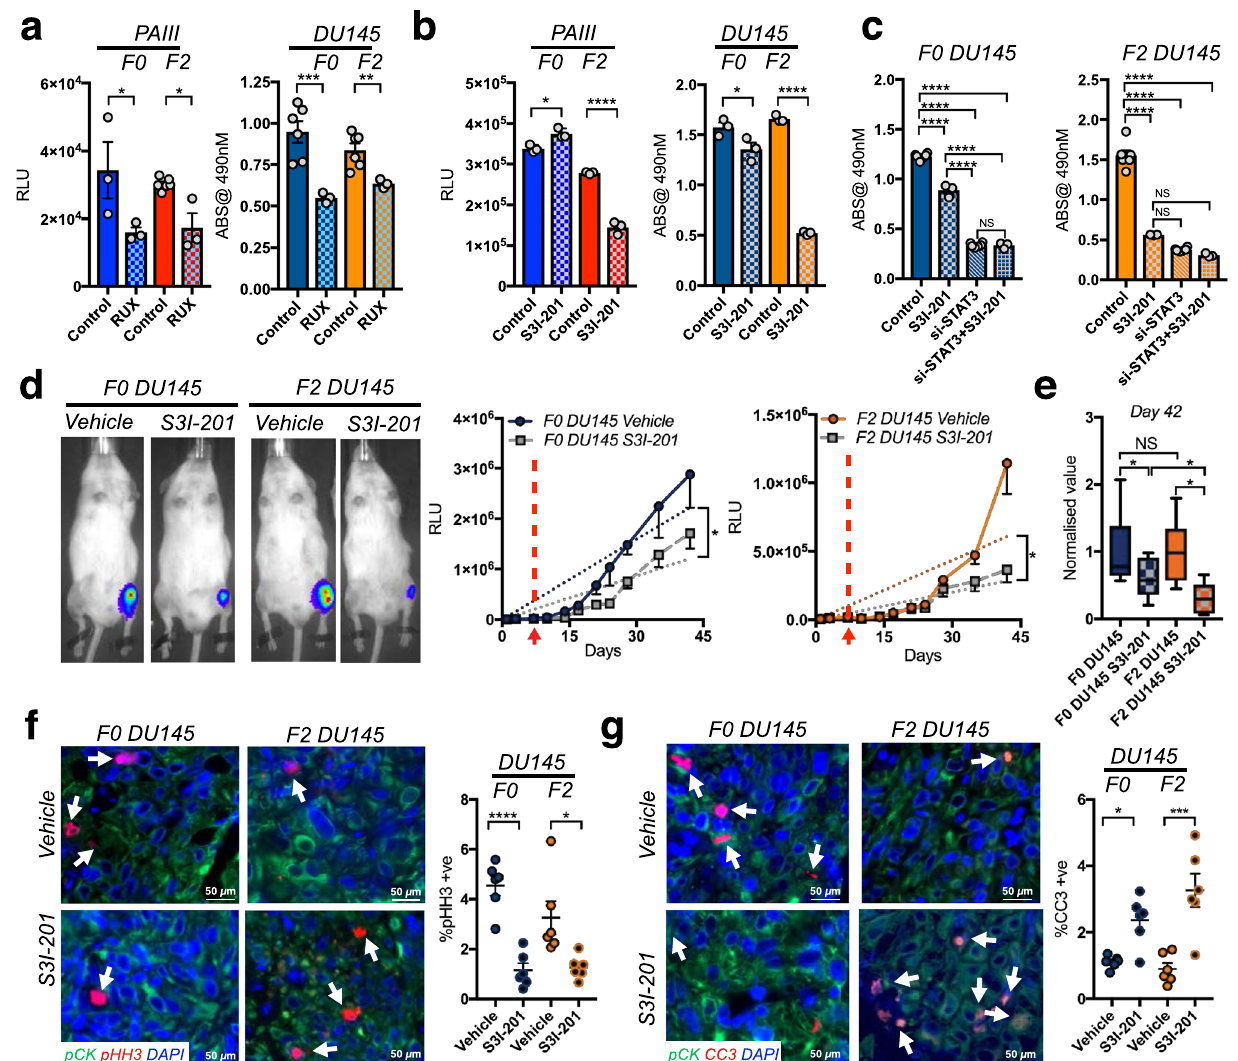
Fig. 7 STAT3 inhibition impairs the growth of MSC-selected prostate cancer in vitro and in vivo. a , b Parental (F0) and MSC-selected (F2) cell lines treated with vehicle control (Control) or the JAK2 inhibitor ruxolitinib (RUX)/STAT3 inhibitor (S3I-201) for 24 h. c F0 and F2 DU145 control (scr-siRNA) or STAT3 silenced (si-STAT3) cells treated with vehicle or S3I-201 for 24 h. d F0 and F2 DU145 growth over time in the presence or absence of STAT3 inhibitor, S3I-201 ( n = 10/group). Representative images of bioluminescence in each group are shown at day 35-time point. Arrow and dashed line represent time of treatment initiation. Graphs illustrate collected RLUs over time for each group. Error bars represent the mean ± SEM and linear regression was used for statistical analysis. e S3I-201 effect on F0 and F2 DU145 at day 42 normalized to respective controls. Box and whisker plots show min to max values obtained. f , g Ex vivo analyses from study endpoint of proliferative and apoptotic indices using phospohistone H3 (pHH3; red arrows; f ) and cleaved caspase 3 (CC3; red, arrows, g ), respectively. Pan-cytokeratin (green) was used to identify prostate cancer cells. Error bars represent the mean ± SEM. Experiments ( a – d ) were repeated on at least three separate occasions with similar results. Error bars in graphs represent the mean ± SEM. Statistical analyses were performed by one-way ANOVA with multiple comparisons at 95% CI. Asterisks denote statistical signi fi cance (* p ≤ 0.05, ** p ≤ 0.01, *** p ≤ 0.001, **** p ≤ 0.0001) while NS denotes not signi fi